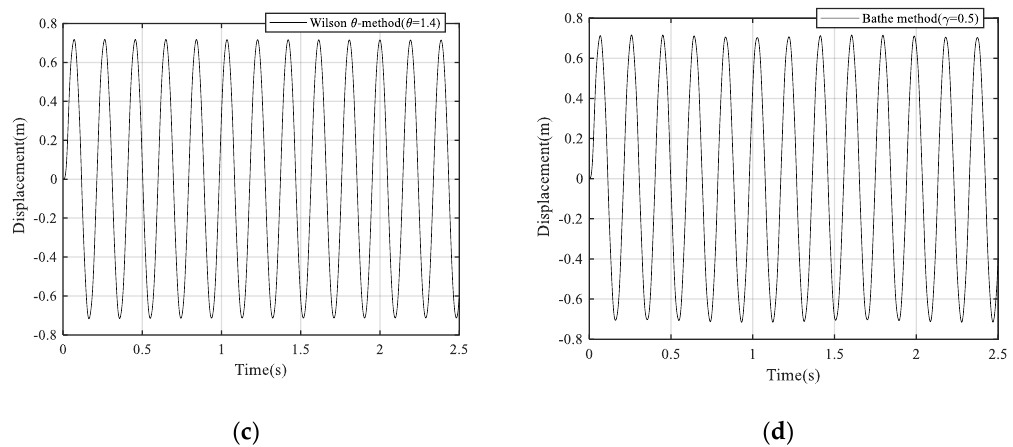
Figure 20. The displacement responses at the free end of the cantilever beam: ( a ) Using the proposed method, ( b ) using the trapezoidal rule, ( c ) using Wilson θ -method, and ( d ) using Bathe method.